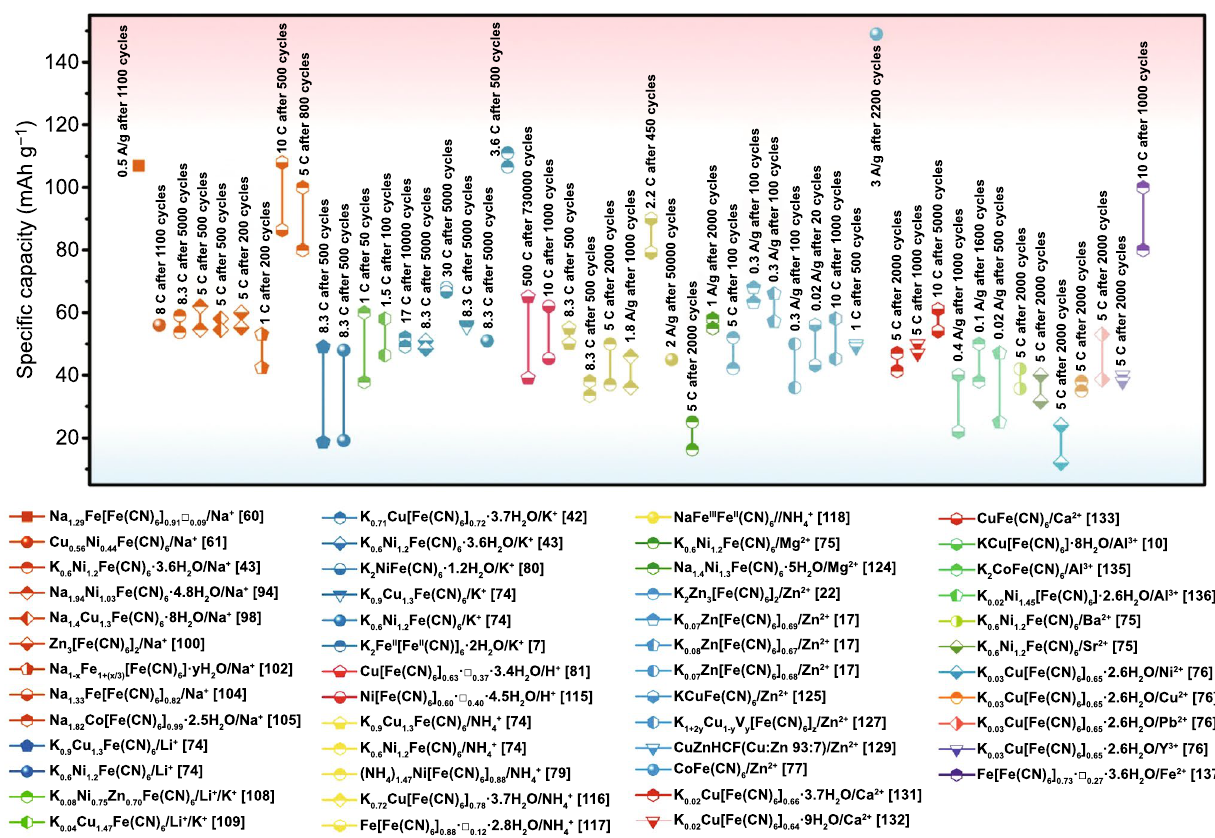
Fig. 13 Cycling performance of different PBAs in various aqueous